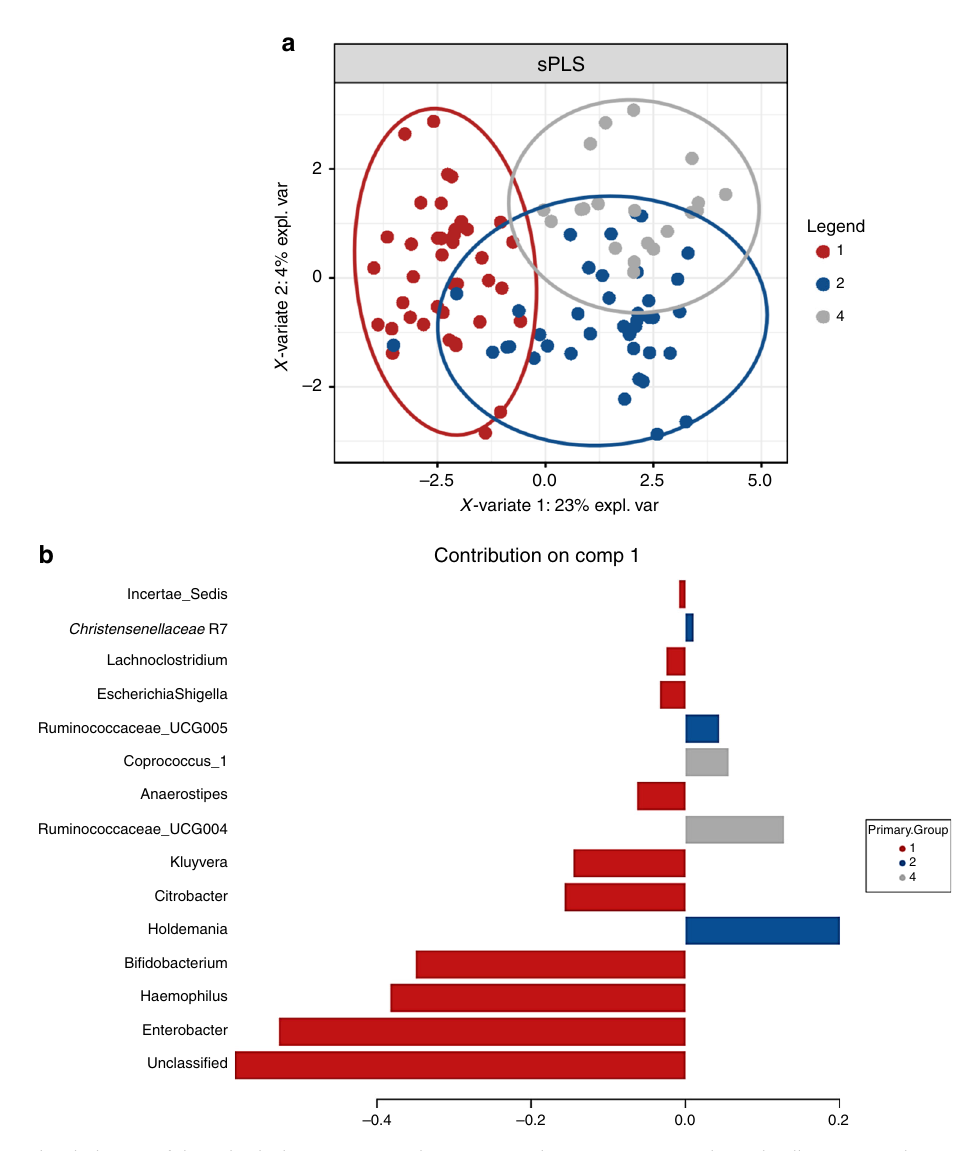
Fig. 6 Taxa associated with the age of the individual. a Sparse Partial Least Squared – Discriminative Analysis plot illustrating a clear separation on repeated measures between years one, two and four using the top 1000 most abundant genera. b The associated contribution plot illustrating taxa associated with each year. Source data are provided as a Source Data fi